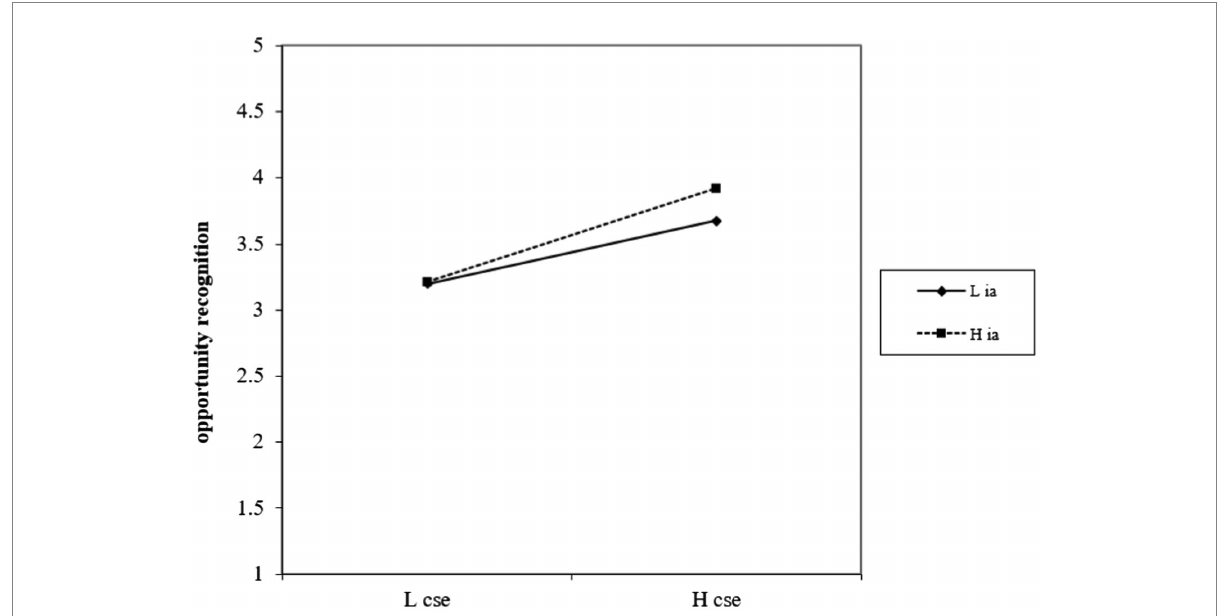
FIGURE 2 Plot of interaction between creative self-efficacy (cse) and opportunity recognition. High support for innovation (ia) is indicated by a square; low support for innovation (ia) is indicated by a diamond.